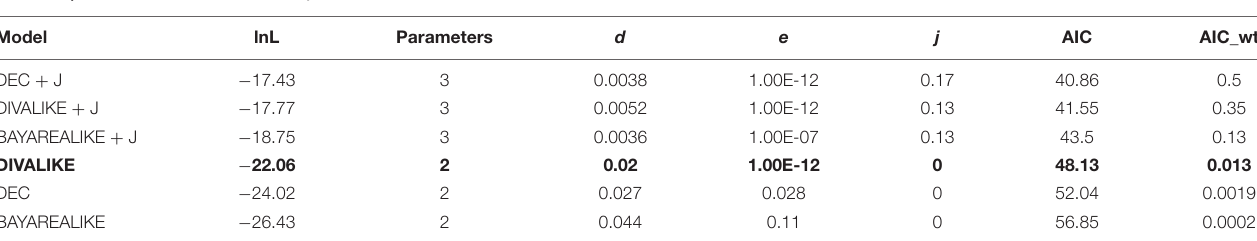
TABLE 3 | Results of BioGeoBEARS analysis for each